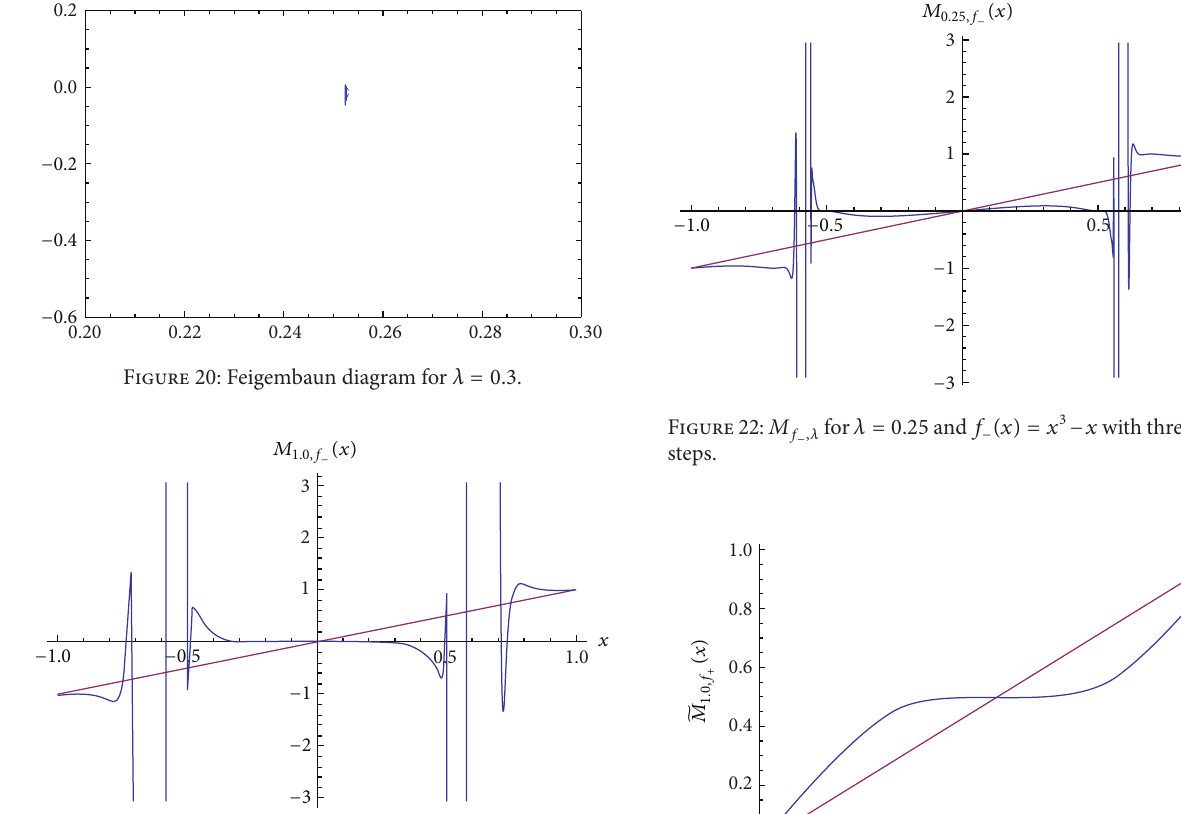
for 𝜆 = 1.0 and 𝑓 − (𝑥) = 𝑥 3 − 𝑥 with three Newton − ,𝜆